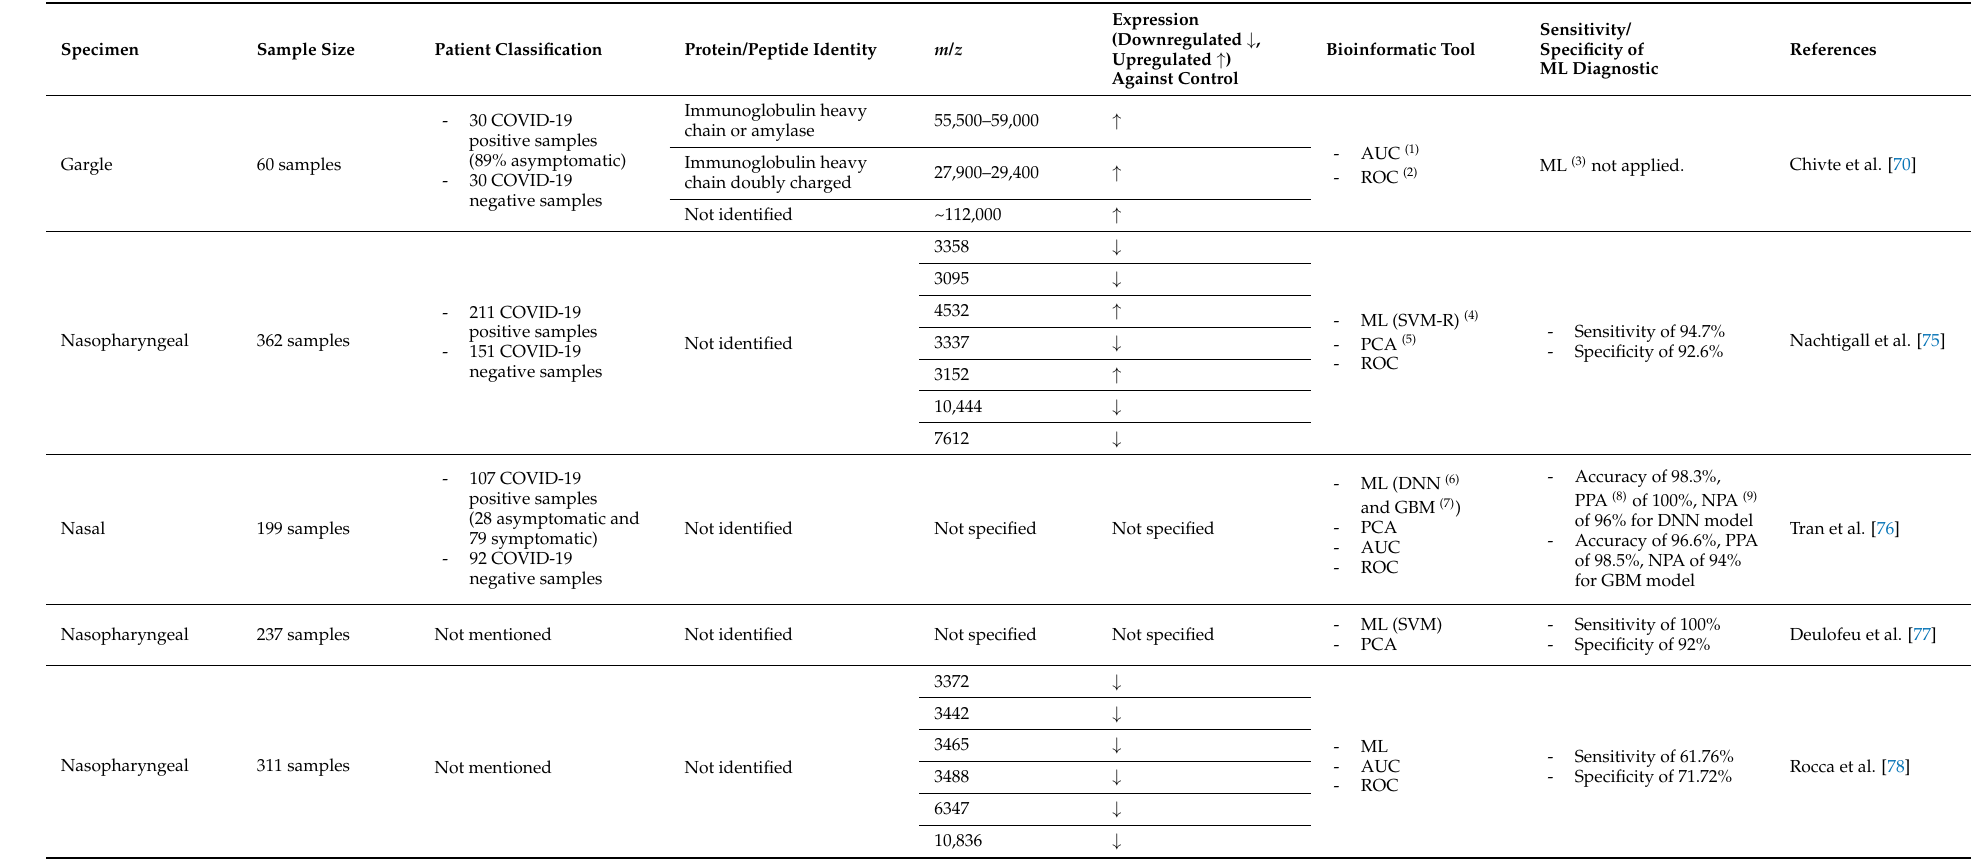
Table 3. Sample size, protein patterns, and their expression trend in COVID-19 vs. non-COVID-19 samples in Biomolecular Host Profiling